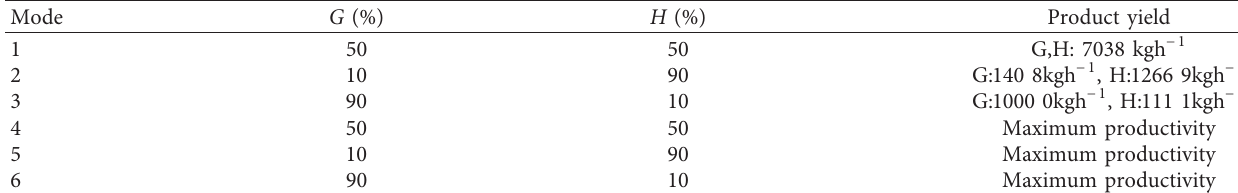
Table 1: The parameters of 6